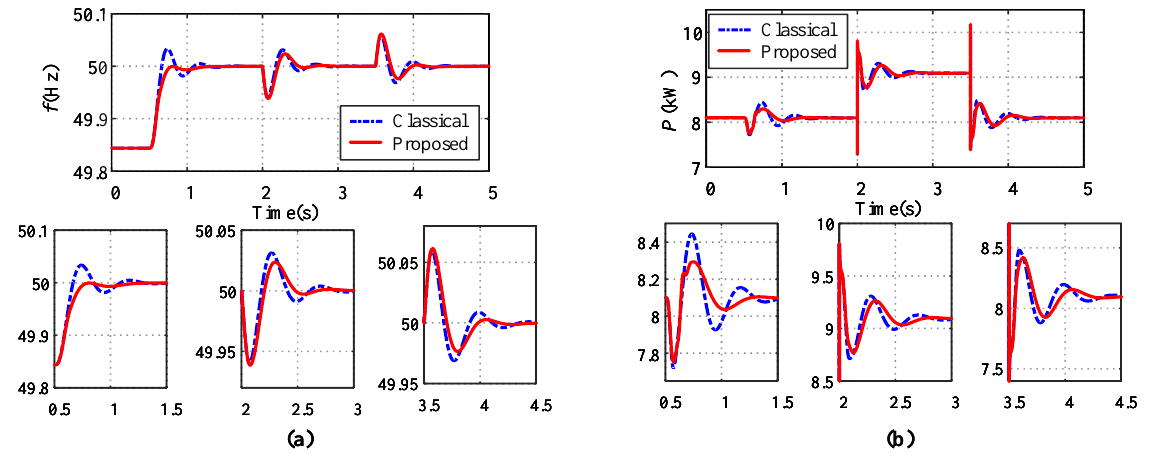
Figure 7. Comparison of convergence speed between the proposed strategy and the classical feedback linearization strategy when τ = 0.2 s: ( a ) frequency of DG1; ( b ) active power of DG1.